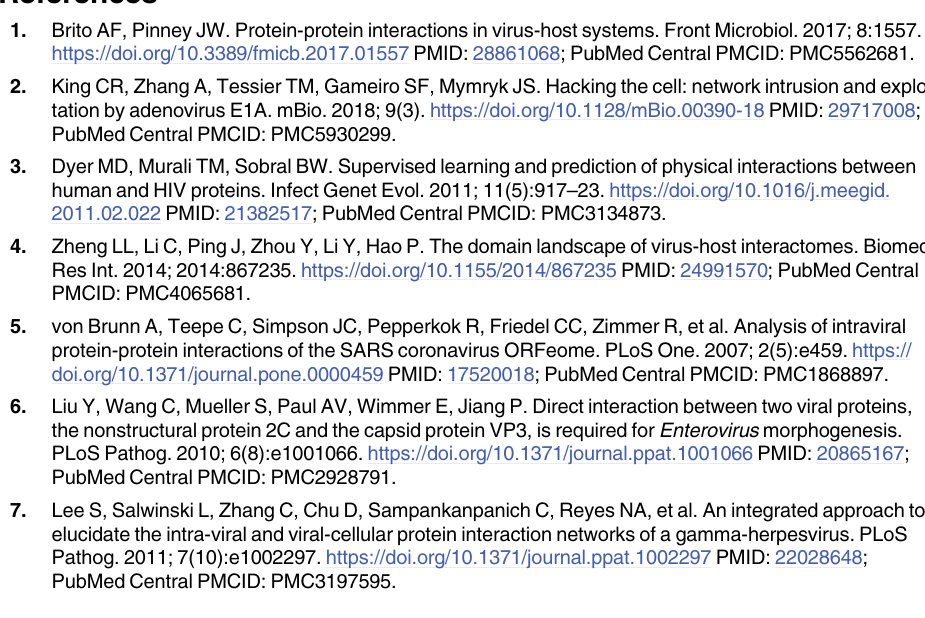
S4 Table. Functional enrichment analysis, related to Fig 6. S5 Table. Functional enrichment analysis, related to S9 Fig. S6 Table. Primers used for cloning in this work. S7 Table. Plasmids used in this work. S8 Table. Primers used for qPCR and RT-qPCR in this